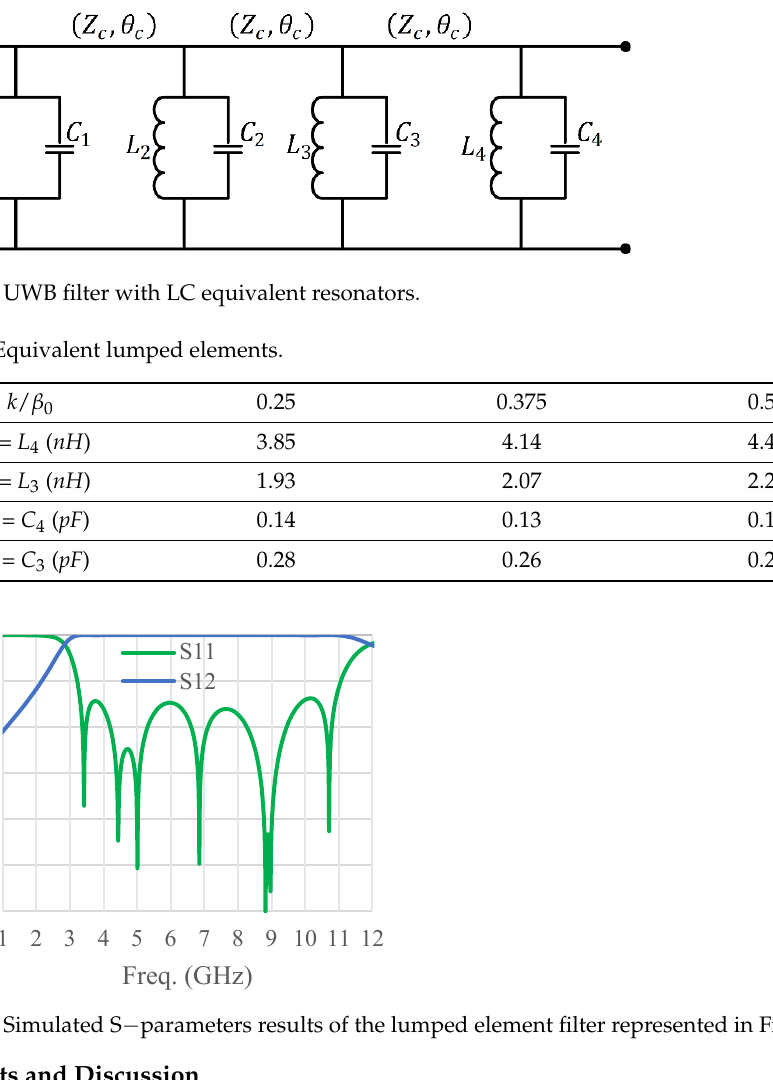
Figure 6. Layout of the proposed microstrip UWB bandpass filters with tapered resonators.